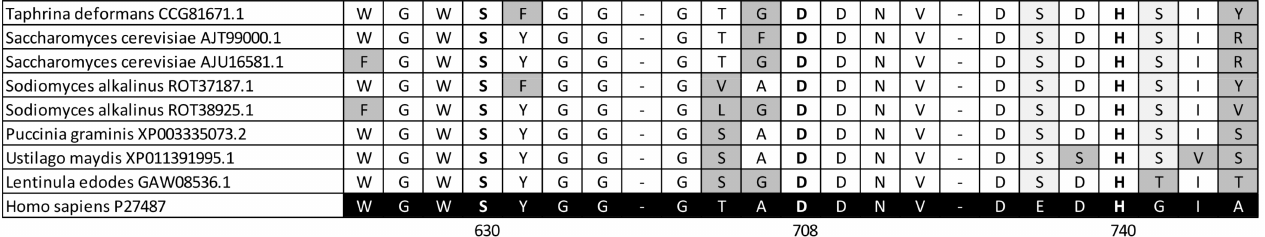
Figure 1. Alignment of conservative DPP4 fragments close to active site in representatives of various subdivisions of higher fungi in relation to human DPP4. Substitutions found in fungi are grayed out, the amino acid residues of DPP4 Homo sapiens are highlighted in black, the conservative amino acid triad is highlighted in bold. Amino acid residue numbers are given for DPP4 H. sapiens